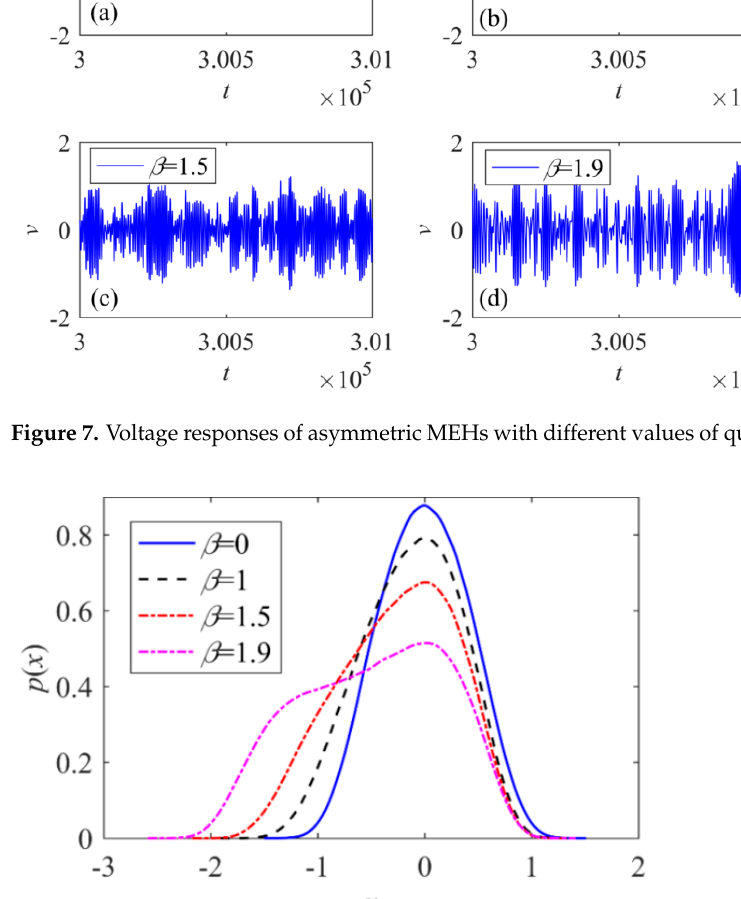
Figure 8. PDF Probability density function of dimensionless displacement for different values of quadratic coefficient.